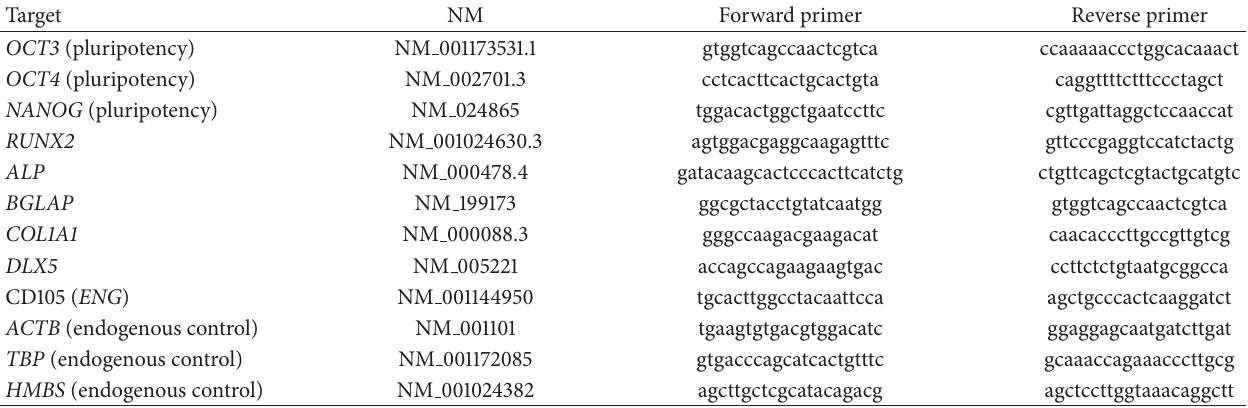
Table 1: Primers used for real-time quantitative PCR